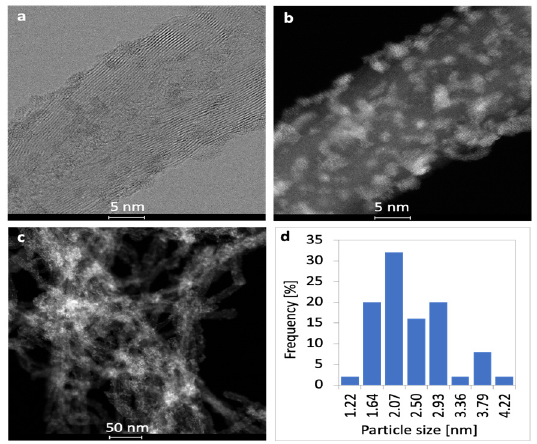
Figure 2. Bright field ( a ) and dark field ( b , c ) TEM pictures of CZ / CNT with CeZrO 2 particle size distribution ( d ).